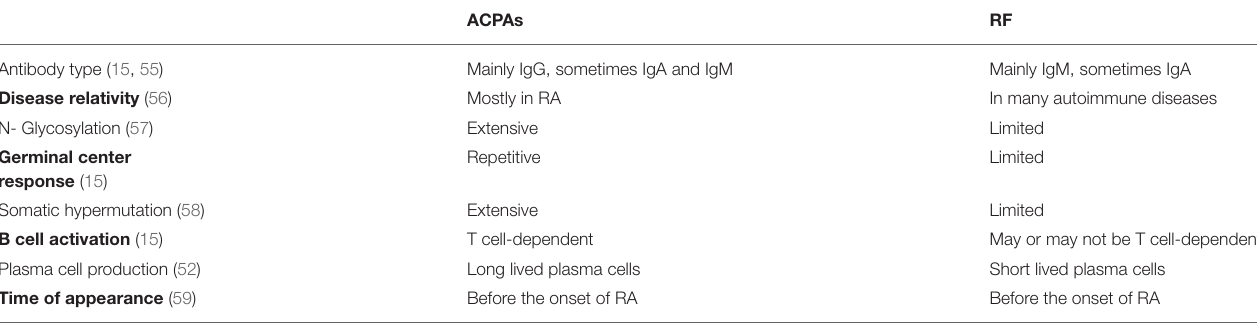
TABLE 1 | Comparison of ACPA and RF